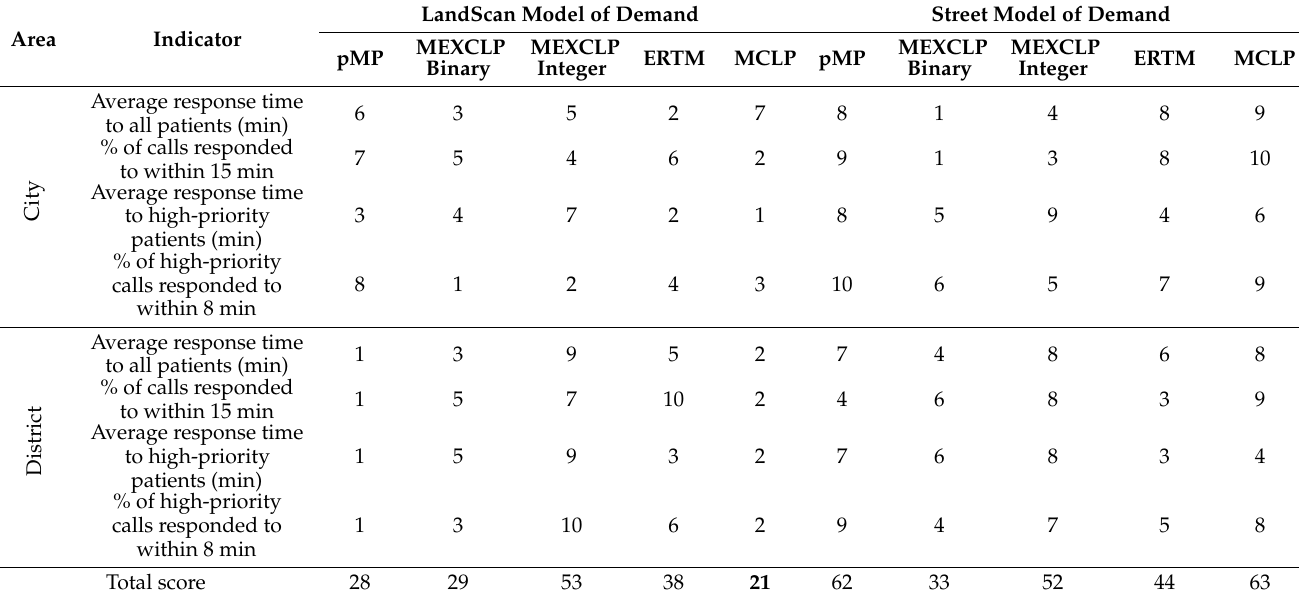
Table 7. Rankings of the location models with regard to simulated